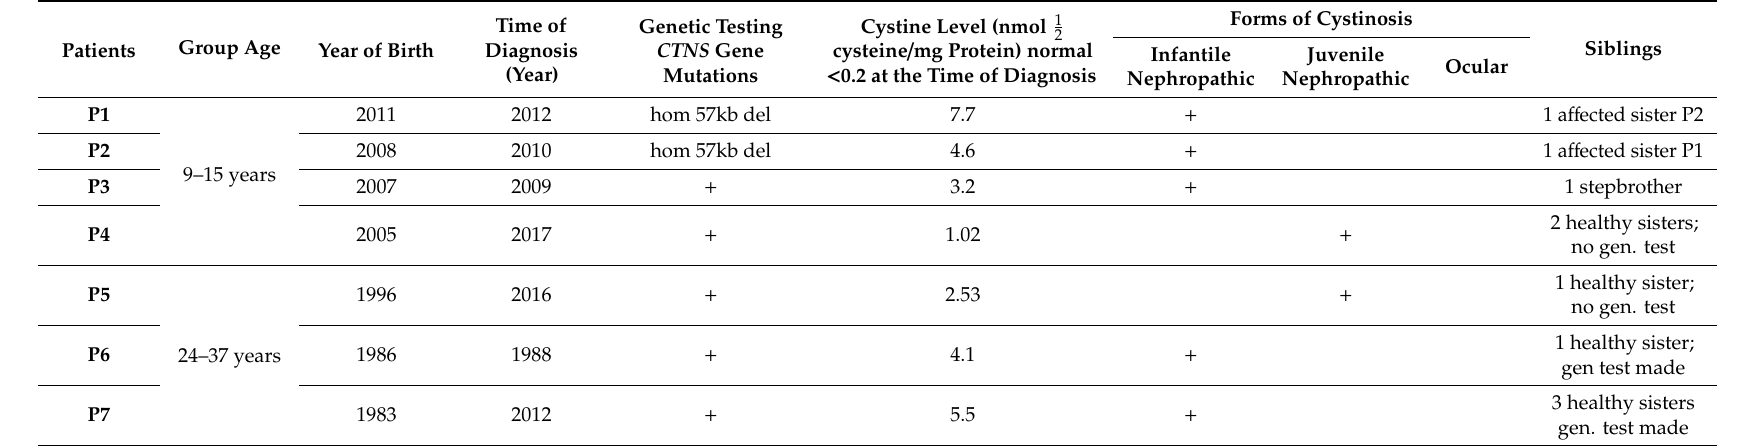
Table 1. Cystinosis presentation divided into two age groups. Genetic analyses confirmed diagnosis of cystinosis in all patients. Cysteine level in leukocytes at the time of diagnosis was above normal content in all patients. Infantile nephropathic form was in 5 patients and juvenile form in